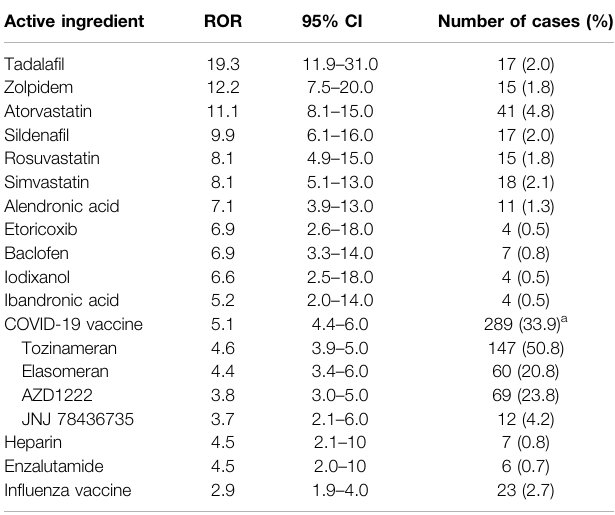
TABLE 2 | Disproportionality analysis for reports of